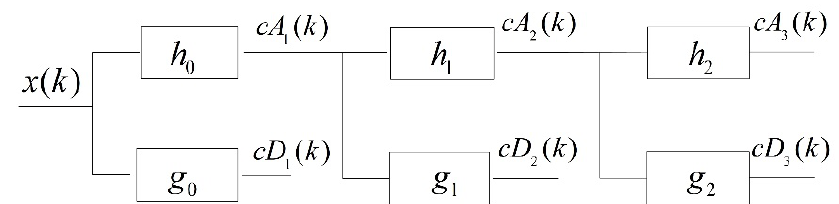
Figure 1. Three-level wavelet decomposition algorithm based on the à trous algorithm, h j represents h 0 up-sampled by 2 j and g j represents g 0 up-sampled by 2 j .